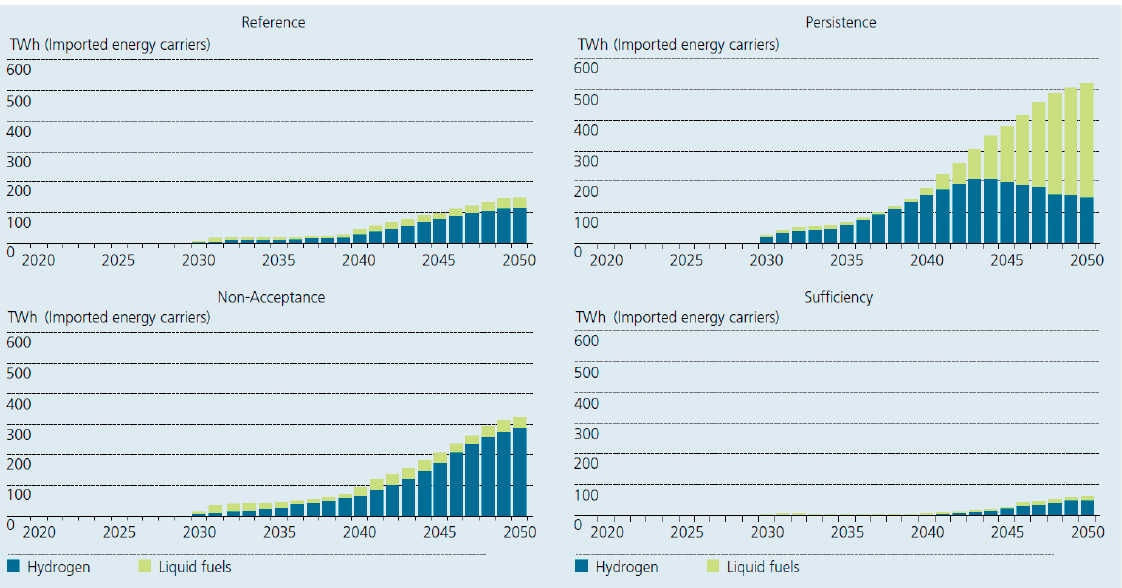
Figure 10. Imports of synthetic fuels generated using green electricity from solar and wind power at sites with high irradiation resources (source: [7]).